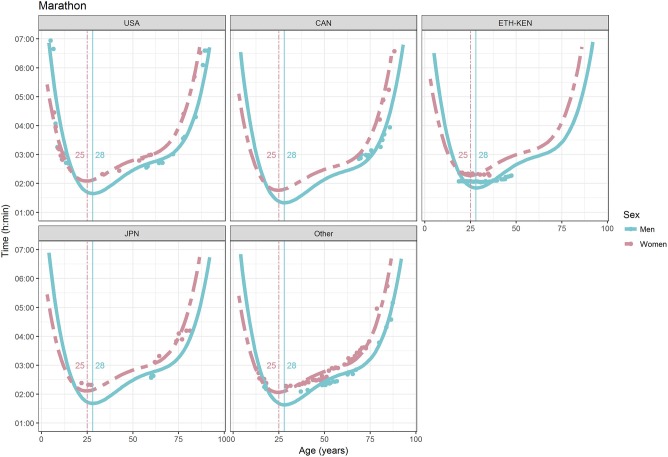
World record in marathon by sex, age (in years), and country. Points were observations. Curves represented quartic degree polynomial regression. Vertical lines with numeric labels were the ages at peak performance.